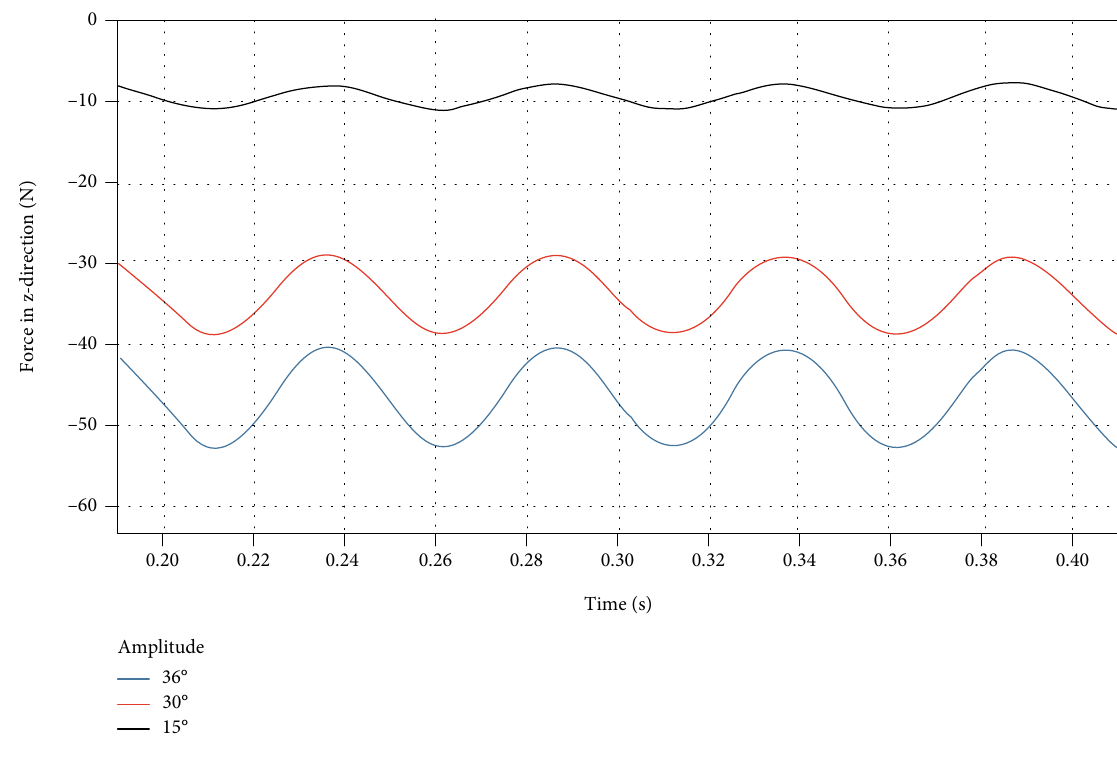
Figure 19: z -direction force on the dorsal fi n at di ff erent swing amplitude.